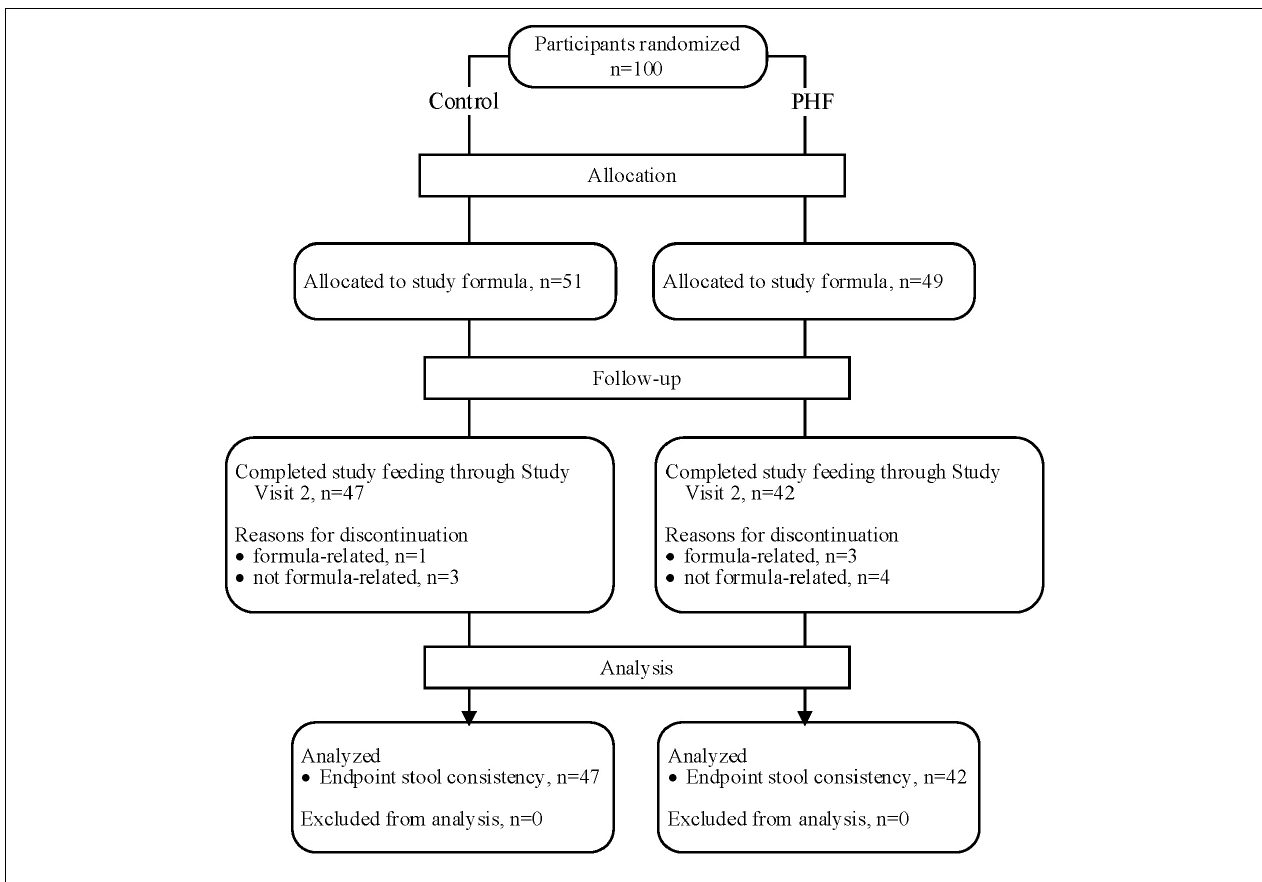
FIGURE 1 | Flow of study